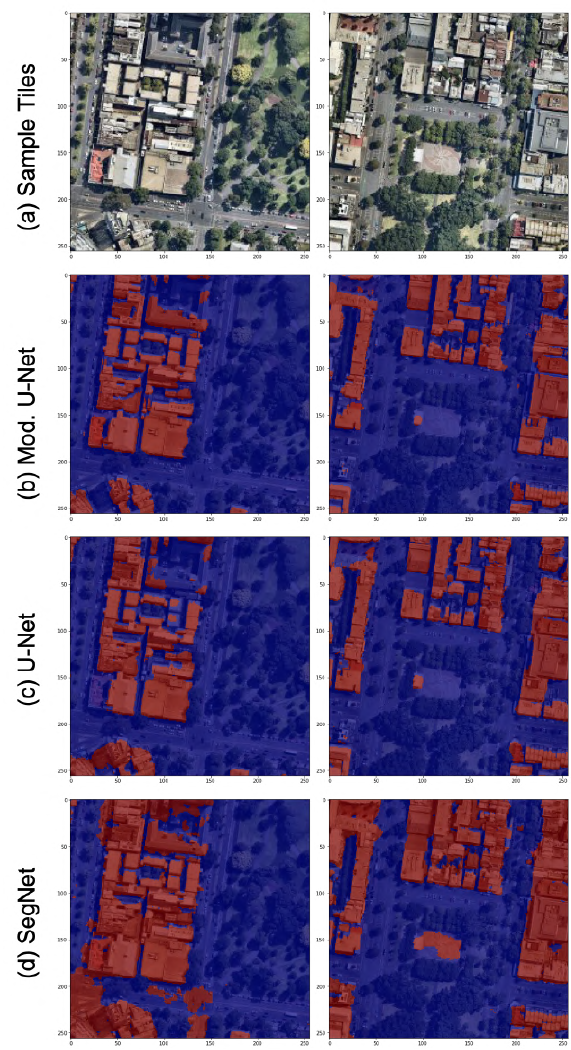
Figure 4 . Sample results from the modified U-Net, U-Net, and SegNet on the Melbourne Building dataset (TR2).